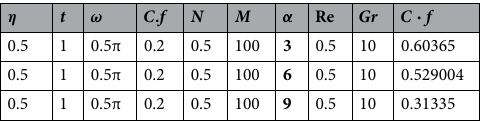
Table 6. Influence of second grade parameter α on skin friction.